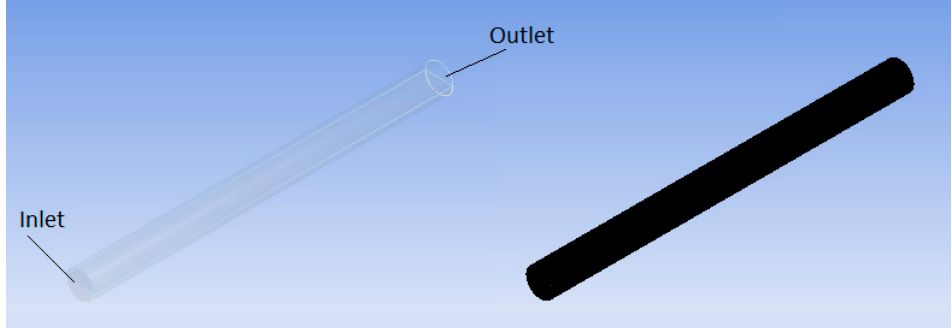
Figure 10. Straight pipe model (left) and straight pipe with mesh (right).